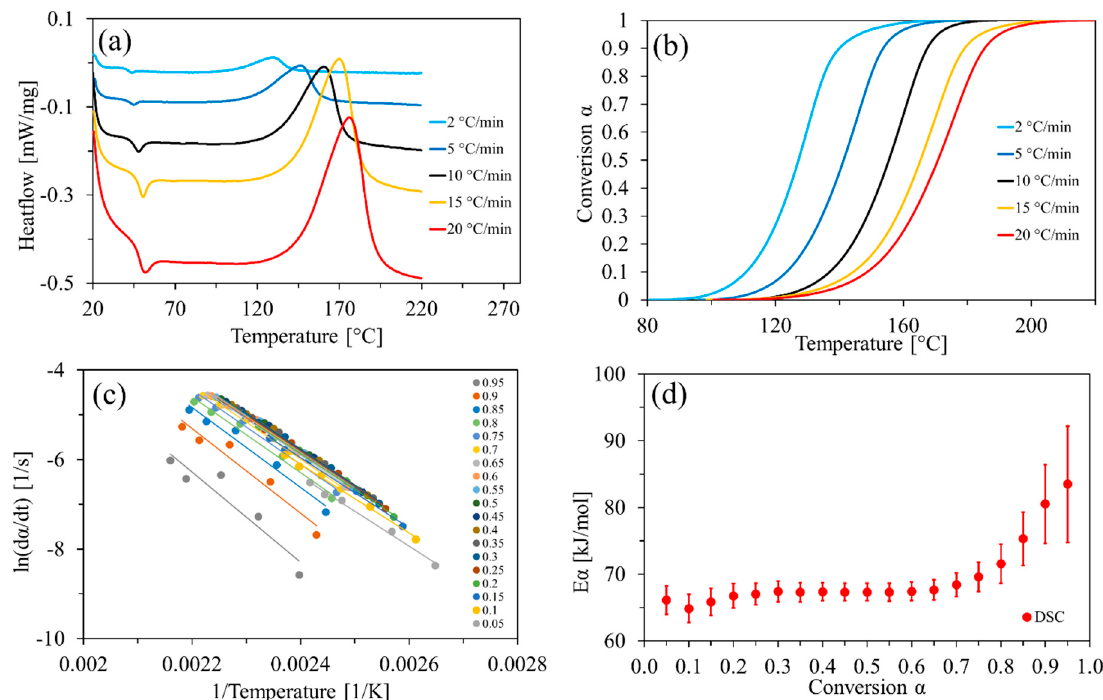
Figure 1. DSC evaluation: ( a ) Heat flow of EMC at different heating rates plotted against the temperature; ( b ) Conversion α plotted against temperature at different heating rates; ( c ) natural logarithm of the reaction rate plotted against the reciprocal of the absolute temperature at specific degrees of cure with the corresponding regression lines (Friedman method); ( d ) apparent activation energy plotted against the degree of cure (Friedman method).